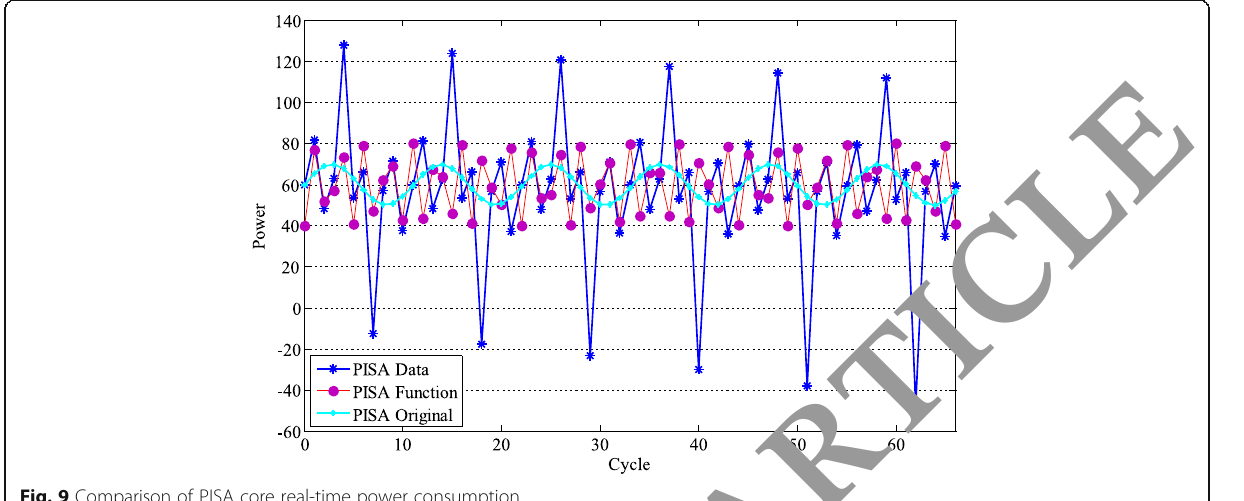
Fig. 9 Comparison of PISA core real-time power consumption